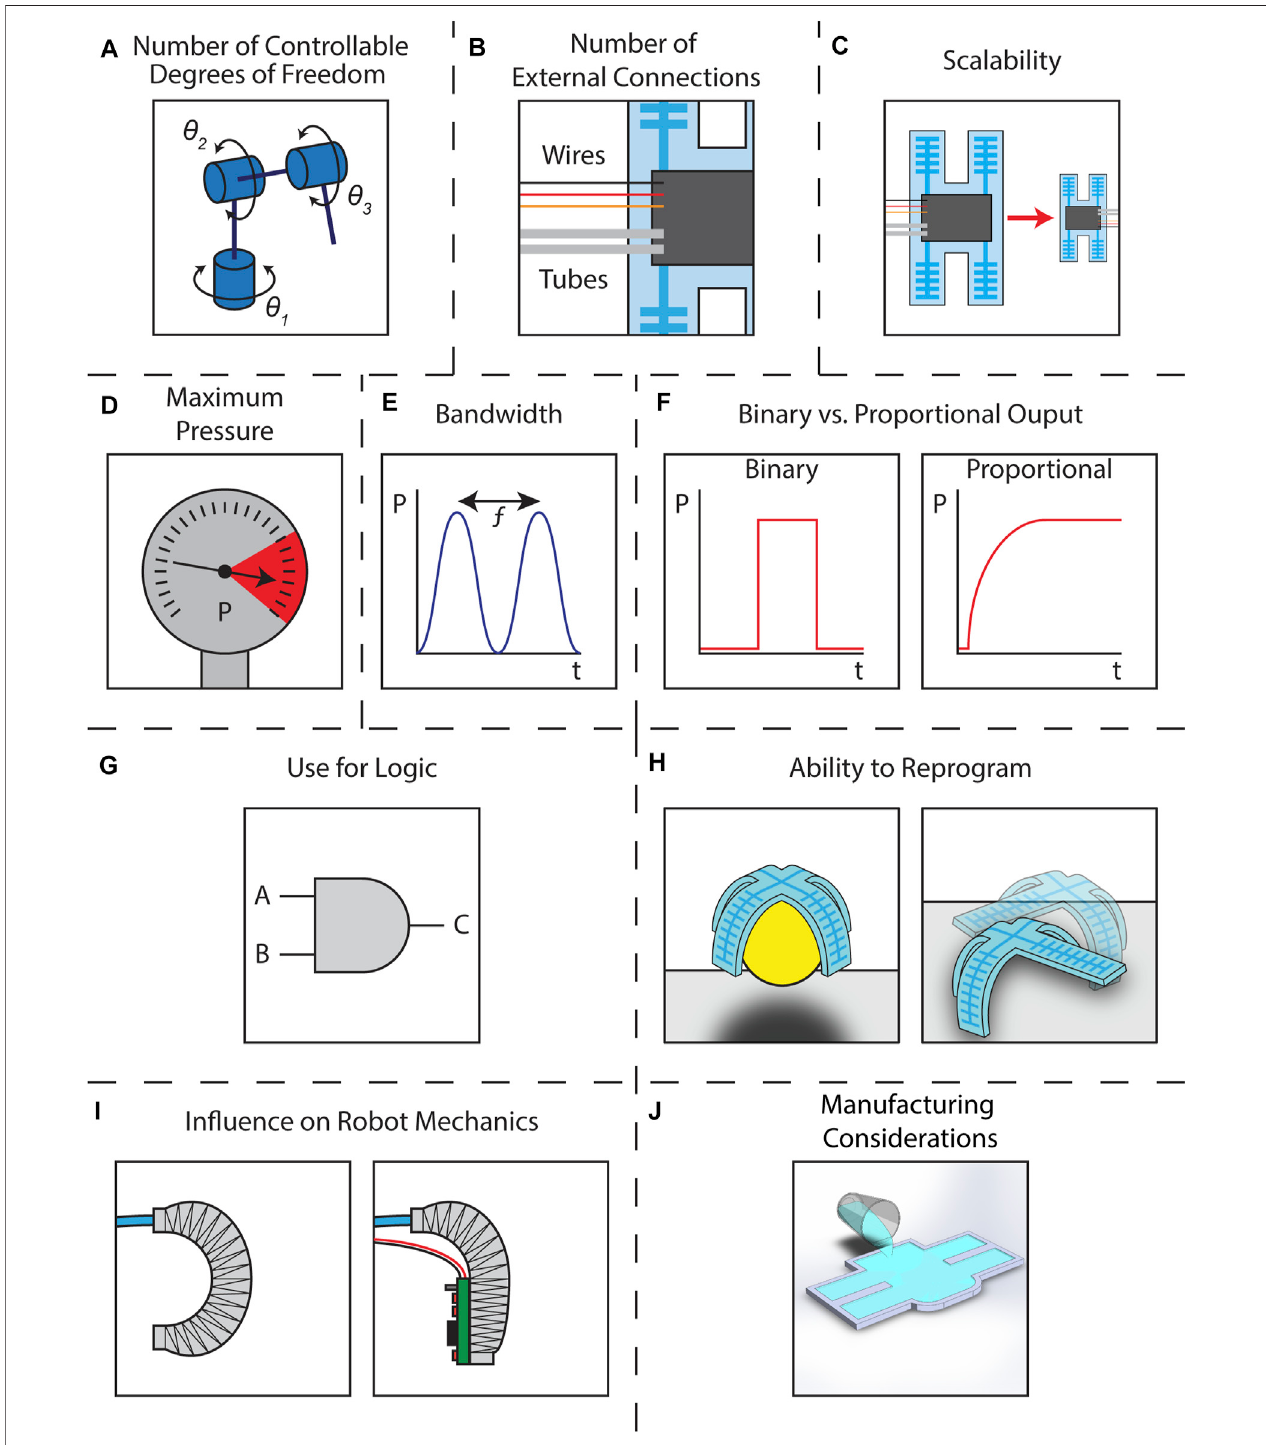
FIGURE2| Schematicsillustratingthecriteriaforcomparison (A) numberofcontrollabledegreesoffreedomrepresentedbyanindustrialrobotwiththreerotational DoFs (B) number of external connections represented by a soft robot with three wires and two fl uidic tubes connected to an arbitrary controller represented by a black box (C) scalability represented by a soft robot manufactured at two scales with the same arbitrary controller represented by a black box (D) maximum pressure represented by a pressure gauge (E) bandwidth represented by the frequency of a pressure signal (F) binary vs. proportional output represented by two pressure vs. time graphs (G) use for logic represented by an “ AND ” gate (H) ability to reprogram represented by a robot (left) grasping an object and (right) walking across a surface (I) in fl uenceofrobot mechanics representedby (left) a fi ber reinforced actuator bending normally and (right) thesame actuator having itsbending inhibited bya rigid control board (J) manufacturing considerations represented by silicone being poured into a mold.